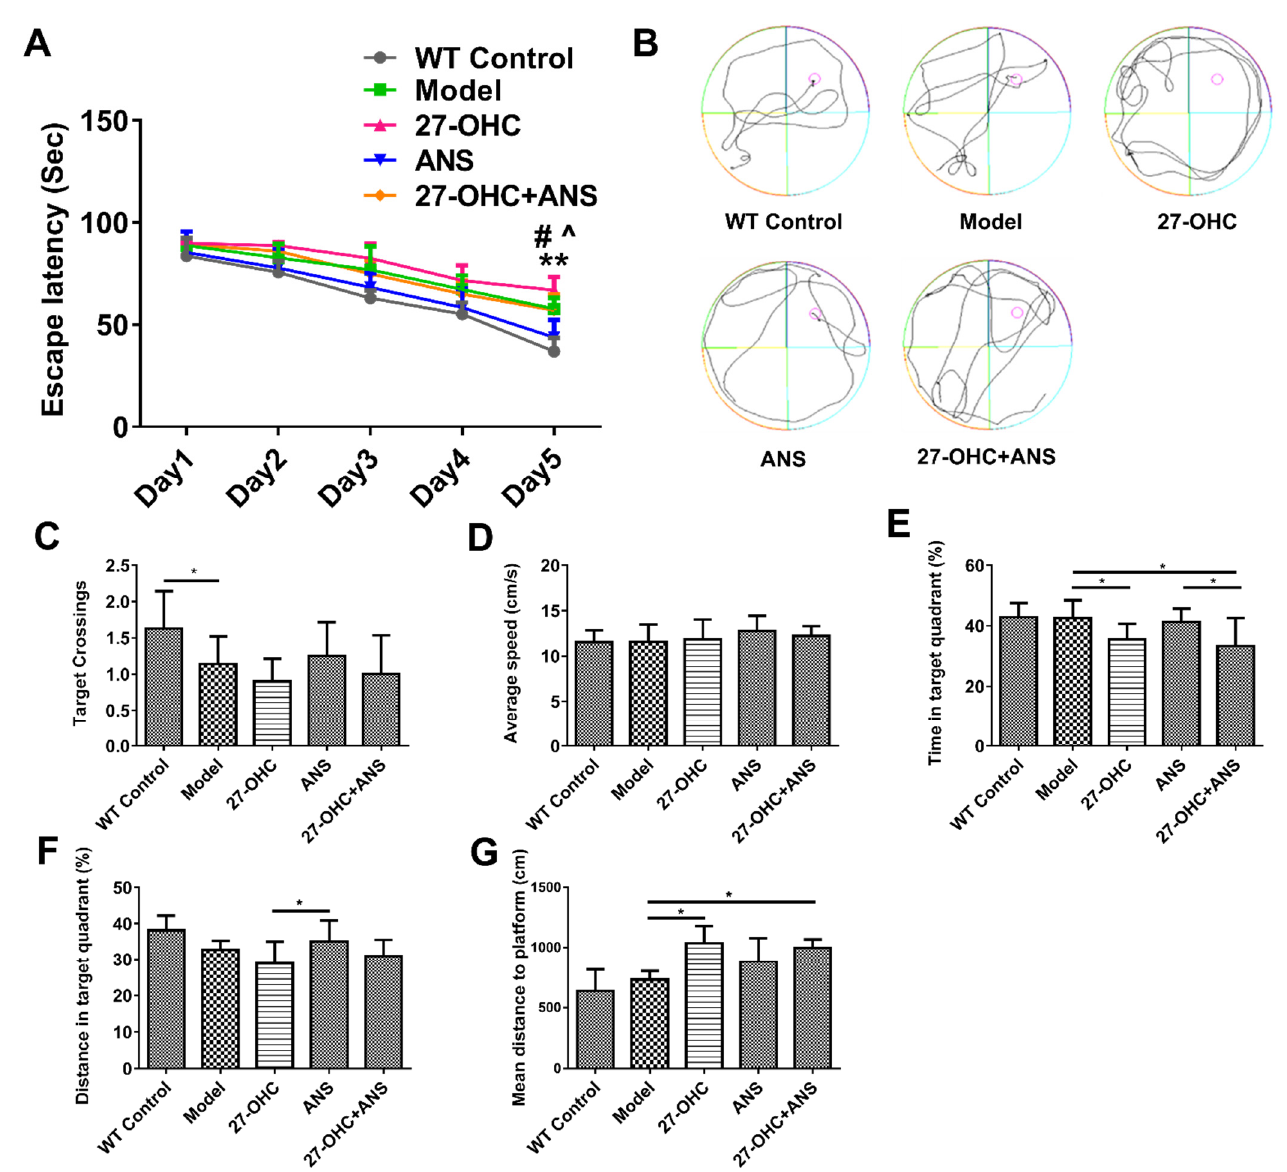
Figure 2. Morris Water Maze test. ( A ) The escape latency of mice changes with time during the training phase. **—All five groups: Day 1 vs. Day 5, p < 0.01; ˆ —27-OHC group vs Model group, p < 0.01; # —27-OHC group vs 27-OHC+ANS group, p < 0.05. ( B ) The paths of mice in the process of exploring the platform. ( C ) The frequency of target crossing. ( D ) The average speed. ( E ) The time in target quadrant. ( F ) The distance in target quadrant. ( G ) Mean distances to platform were measured by Morris water maze test. All data are shown as mean ± SD (repeated measures ANOVA and one- way ANOVA). * p < 0.05; ** p < 0.01.